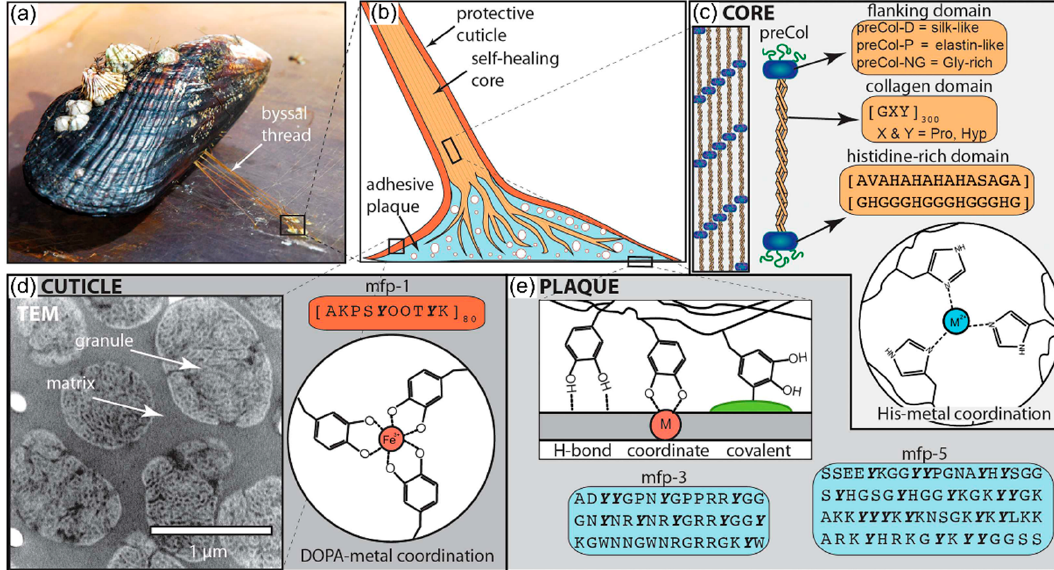
Figure 13. Structural hierarchy of the mussel byssus. ( a ) Mussels anchor onto surfaces by means of a byssus. ( b ) Individual byssal threads consist of a fibrous core, which is protected by a thin cuticle and ends in an underwater adhesive plaque. ( c ) The core is comprised of collagenous modular proteins, referred to as prepepsinized collagens (preCols), which are organized into a semicrystalline framework and stabilized by histidine–metal coordination bonds. ( d ) The cuticle, which resembles a particle-reinforced composite, comprises mainly a repetitive 3,4-dihydroxyphenylalanine (DOPA)-rich protein, mfp-1, which is cross-linked via metal coordination bonds with Fe 3+ . ( e ) Plaque adhesion is mainly mediated by DOPA and Lys-rich proteins mfp-3 and mfp-5, which utilize DOPA to create a range of interactions with surfaces. In the protein sequences above, bold and italicized Y represents DOPA. Reprinted from [67] by permission of John Wiley & Sons, Inc.